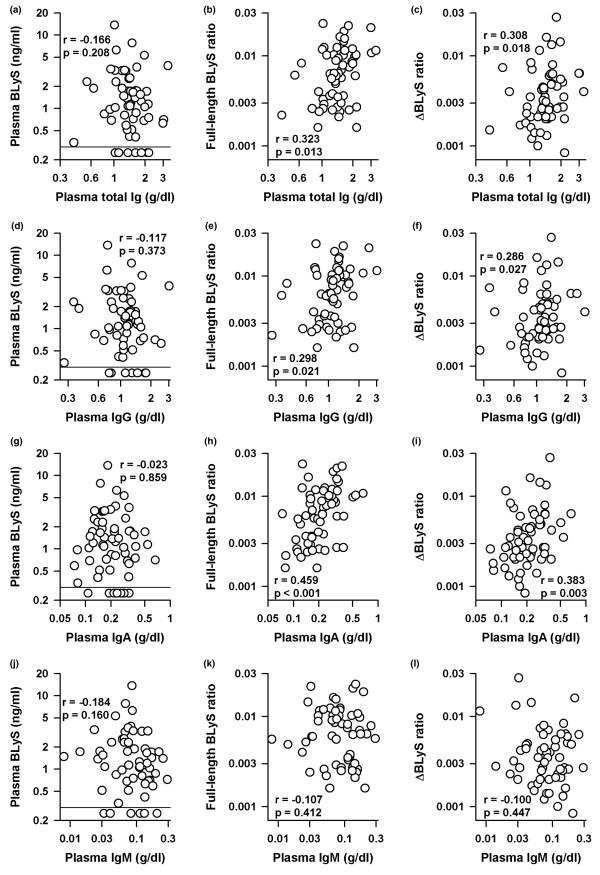
Correlations in the SLE patients between BLyS parameters and plasma immunoglobulin levels. Individual (a,d,g,j) BLyS protein levels, (b,e,h,k) full-length BLyS mRNA levels, and (c,f,i,l) ΔBLyS mRNA levels are plotted against corresponding plasma total immunoglobulin levels (a–c), IgG levels (d–f), IgA levels (g–i), and IgM levels (j–l). BLyS, B lymphocyte stimulator; IL, interleukin.